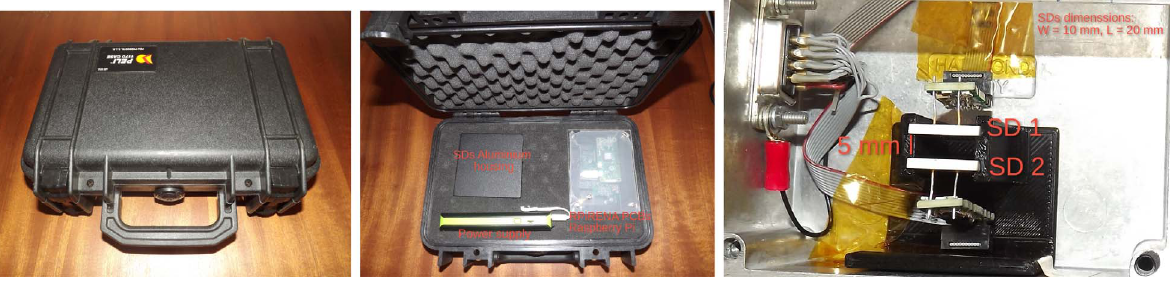
Figure A.2. External (left panel) and interior (middle panel) dosimeter housing used for the test fl ights. The right panel shows a close-up view of silicone diodes (SDs), labelled SD 1 and SD 2, in telescope mode with a separation of 5